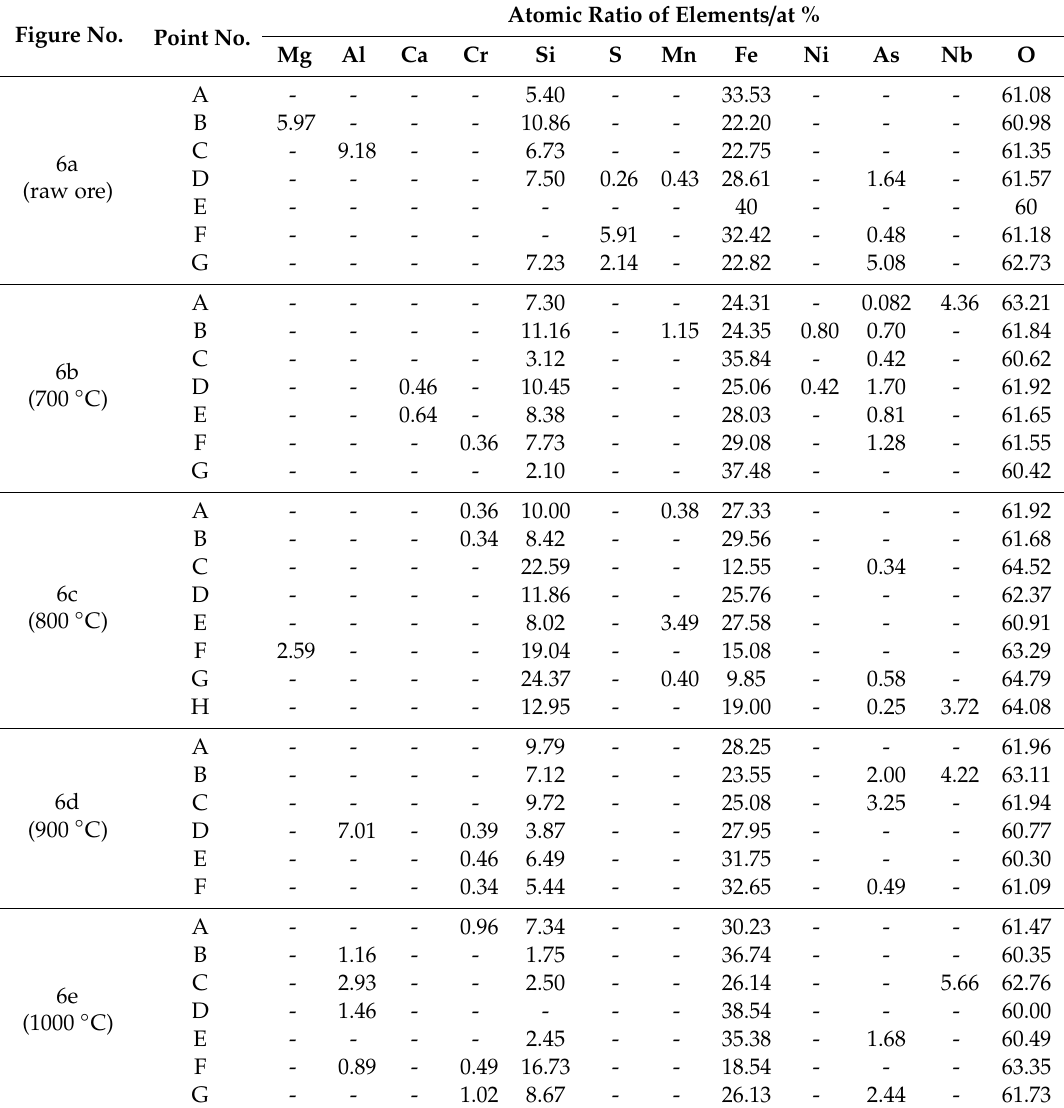
Table 4. Chemical composition of the raw ore and roasted